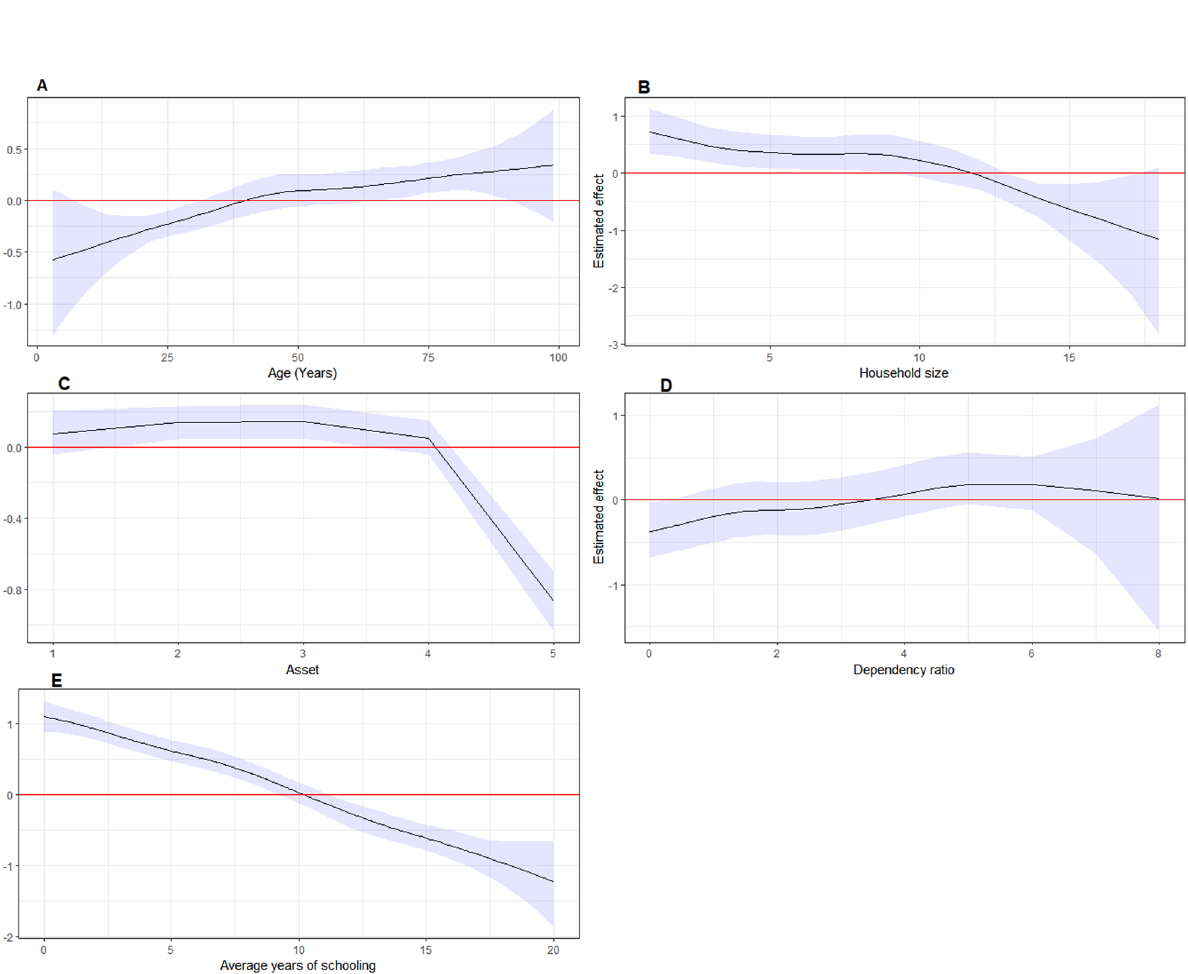
Figure 5. Non-linear effects of continuous predictors (with 95% CI) of geo-additive model: ( A ) Age of the household; ( B ) Household size; ( C ) Household assets index; ( D ) dependency ratio; ( E ) Average years of schooling of all family